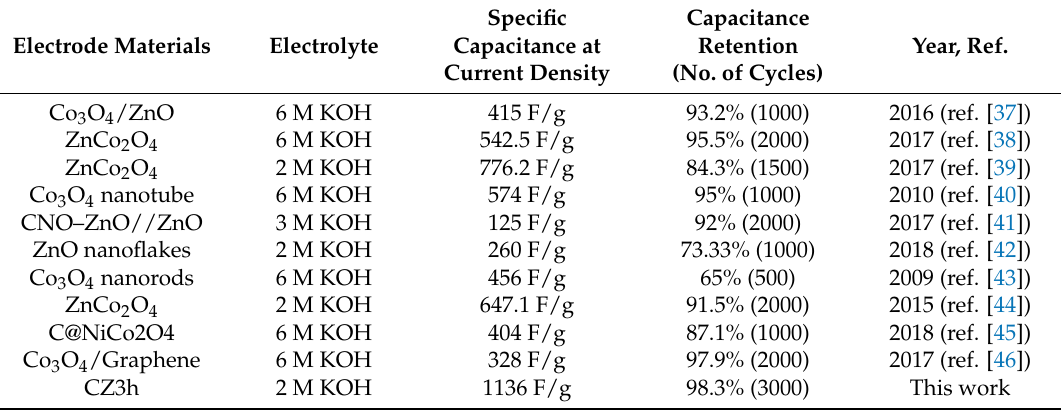
Table 1. Comparison of various zinc- or cobalt oxide-based electrode materials and their electrochemical performances taken from recently published reports and the present work.